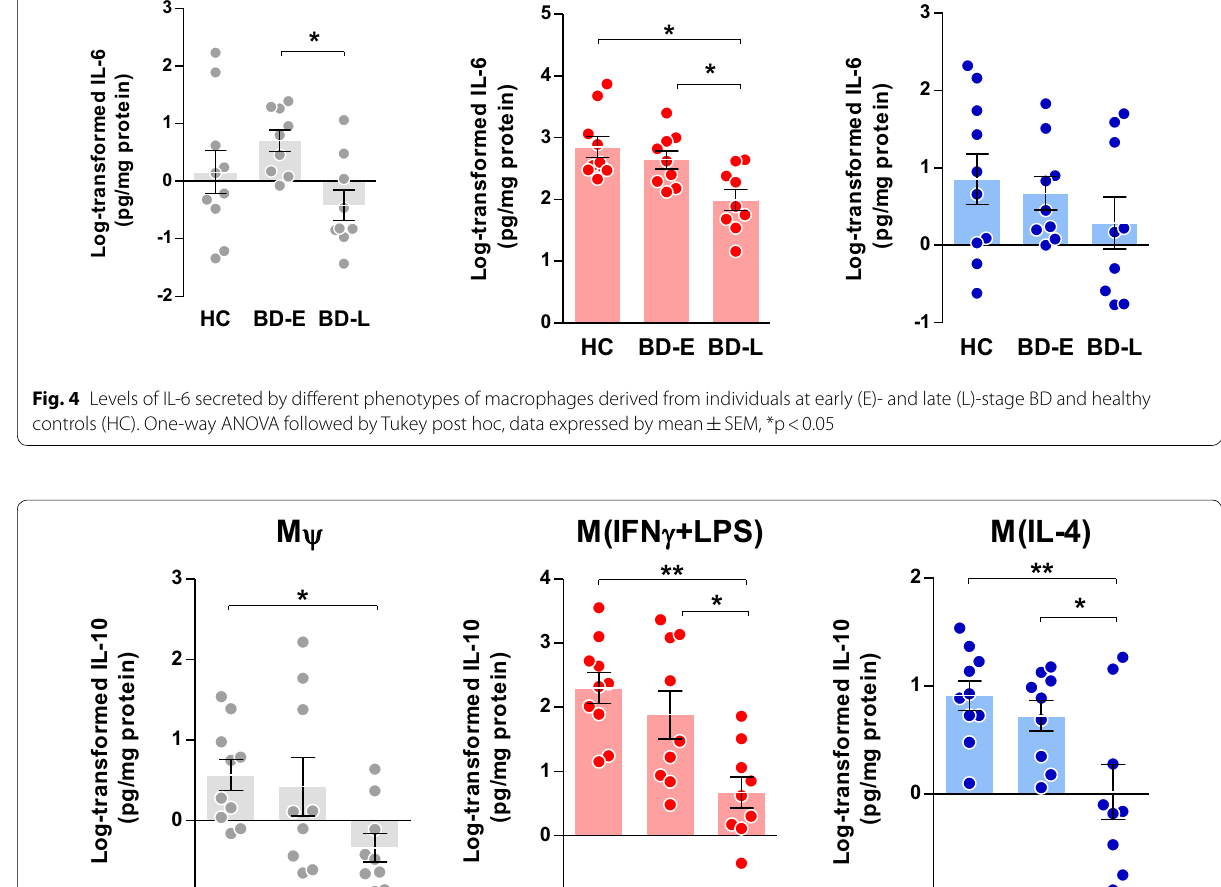
Fig. 5 Anti‑inflammatory IL‑10 secretion by different phenotypes of macrophages derived from individuals with BD at early (E) and late (L) stages and healthy controls (HC). One‑way ANOVA followed by Tukey post hoc, data expressed by mean